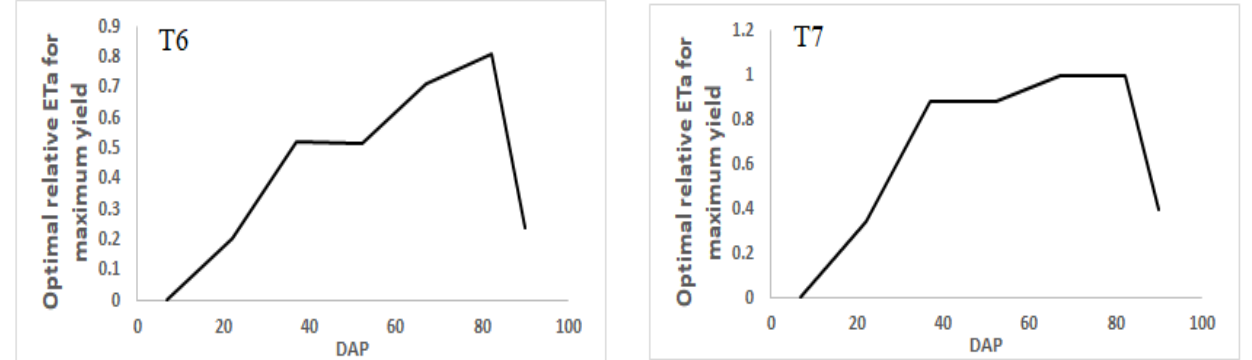
Figure 9. Optimal relative ETa for wheat under different levels of seasonal-irrigation water.